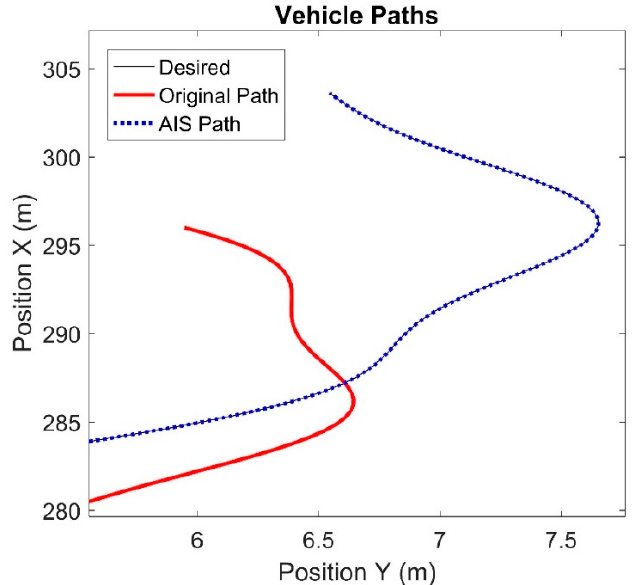
Figure 11. An enlarged view of the end of the trajectories in Figure 10. The desired trajectory of the vehicle (black) is shown along with the original path the faulted vehicle (red) the path the vehicle would follow after compensation from the AIS (blue dots).